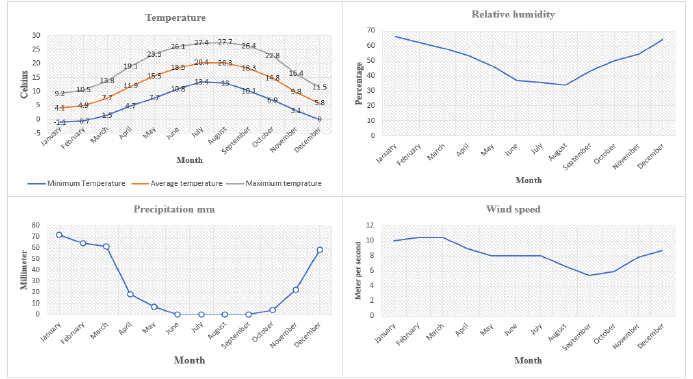
Figure 4. Climate data for Petra,